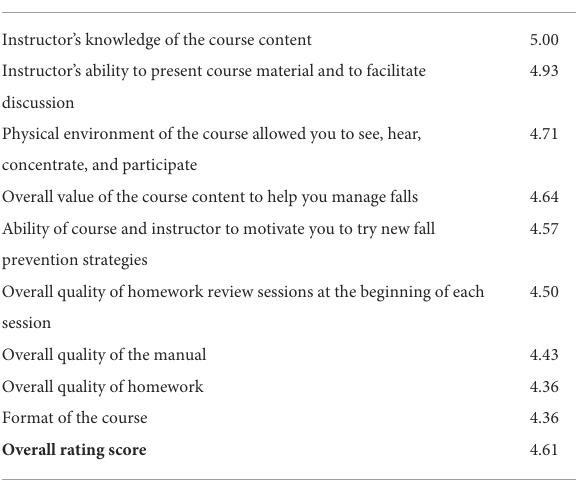
TABLE 7 Summary of iROLL-O’s post-course participant satisfaction (on scale of 1–5: 1 = poor; 5 = excellent).